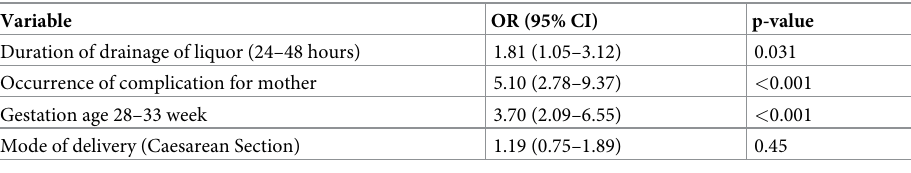
Table 4. Multivariate analysis showing risk of perinatal